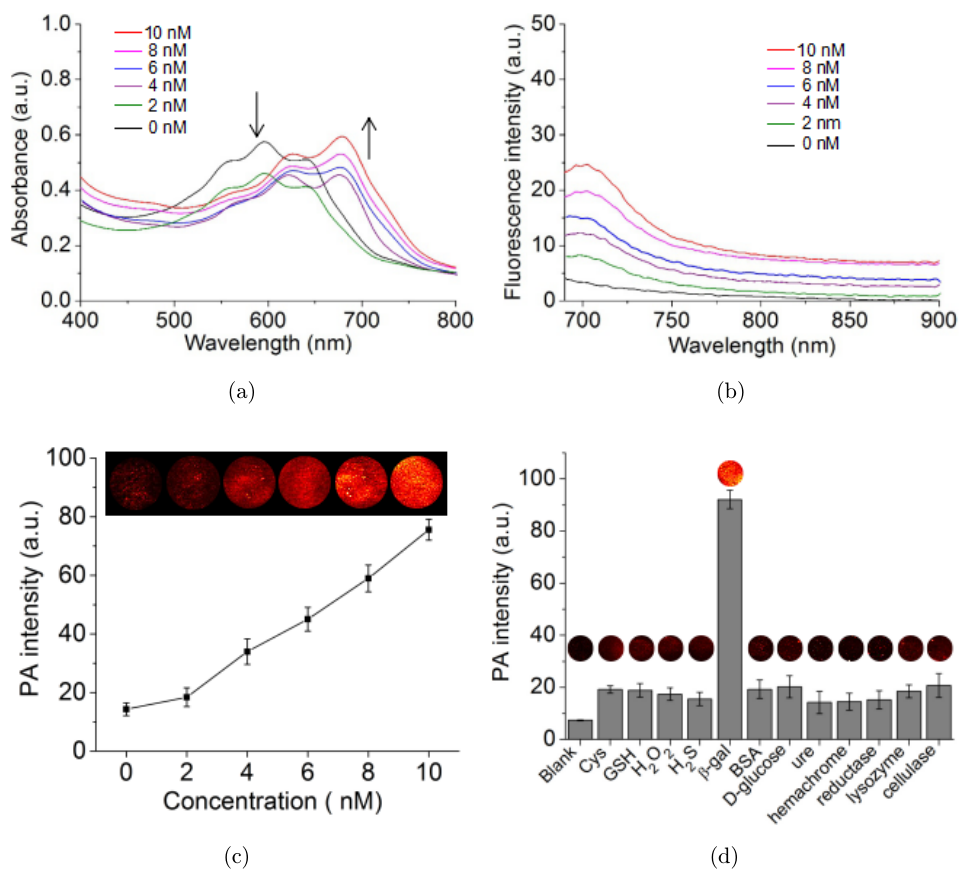
Fig. 2. Absorption and °uorescence spectra of Cy7- (cid:1) -gal and with the addition of (cid:1) -gal. (a) Absorption spectra of Cy7- (cid:1) -gal (5 (cid:2) M) and after reacted with (cid:1) -gal (0 – 10 nM). (b) Fluorescence spectra nM of Cy7- (cid:1) -gal (5 (cid:2) M) upon addition of (cid:1) -gal (0 (cid:1) 10 nM). (c) PA images and PA intensity of the Cy7- (cid:1) -gal solution in the presence of (cid:1) -gal (0 (cid:1) 10 nM). (d) PA images and PA intensity of Cy7- (cid:1) -gal (5 (cid:2) M) in the presence of representative various biospecies (Cys, GSH, H 2 O 2 ; H 2 S, (cid:1) -gal, BSA, D -glucose, urea, hemachrome, reductase, lysozyme and